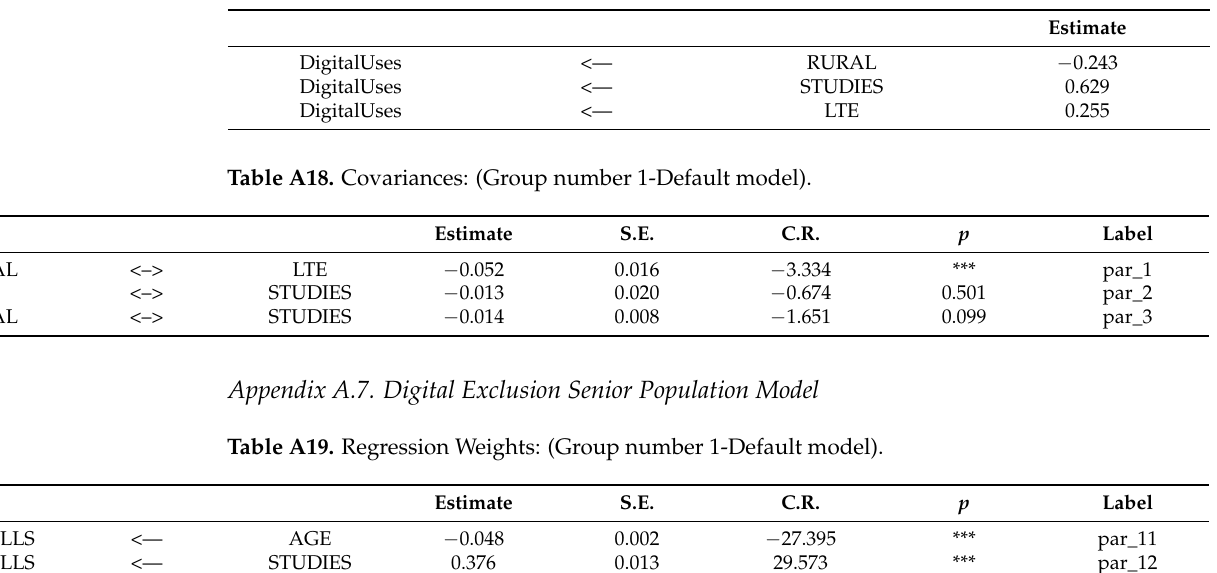
Table A17. Standardized Regression Weights: (Group number 1-Default model).